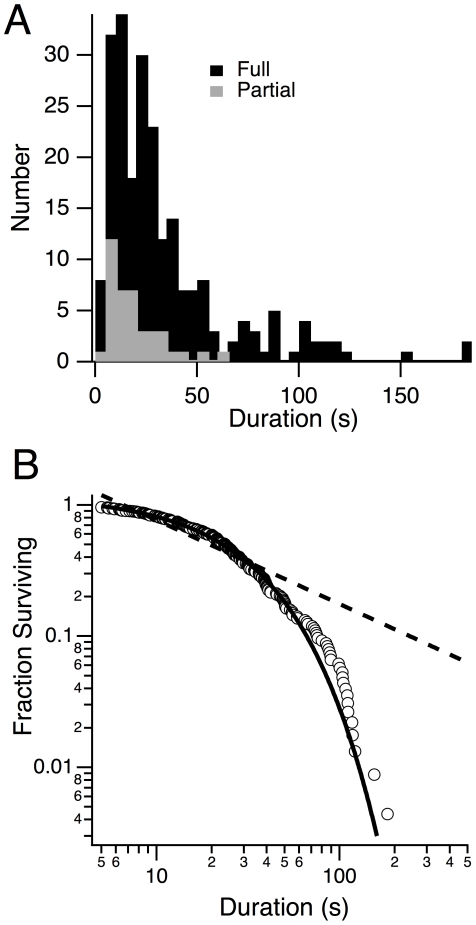
Behavioral arrest duration in DKO mice are well fit by an exponential distribution.(A) Distributions of full (black bars) and partial (grey bars) arrest bout durations. (B) Survival analysis of full arrest bouts. Fraction of bouts longer than each duration are plotted on a double log scale (open symbols). The best fit exponential (solid line) and power functions (dashed line) are superimposed. Arrest lifetimes are poorly fit by a power function but very well fit by the exponential. A small fraction (<13%) of arrests are longer than expected for the best fit exponential relation and clustered around 100 s.